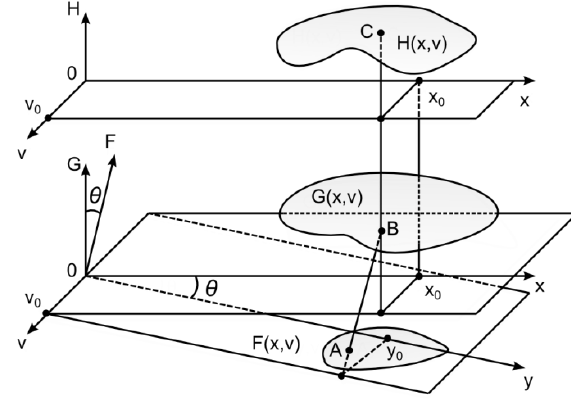
Figure 8. Schematic representation of the projection